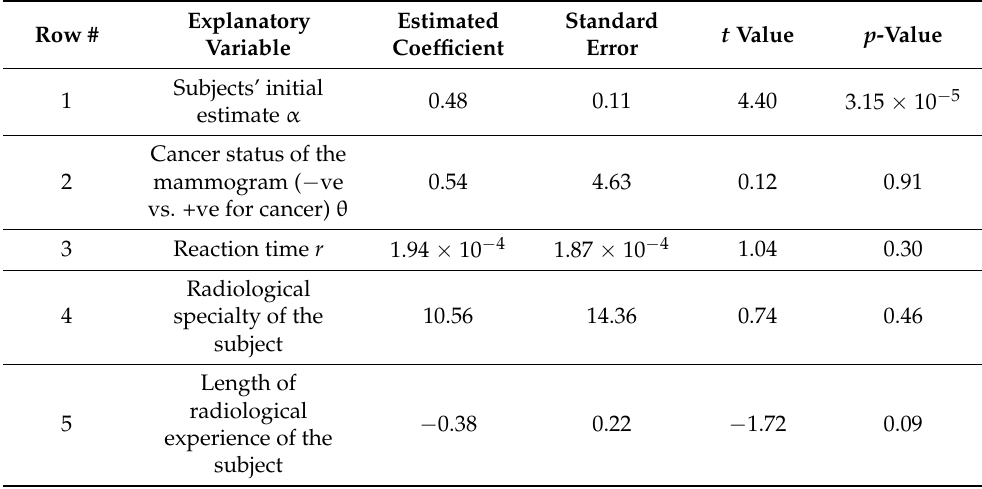
Table 3. Contribution of the various explanatory variables to the final estimates γ when anchoring information was available in Study 2 (conditions 1 and 2).